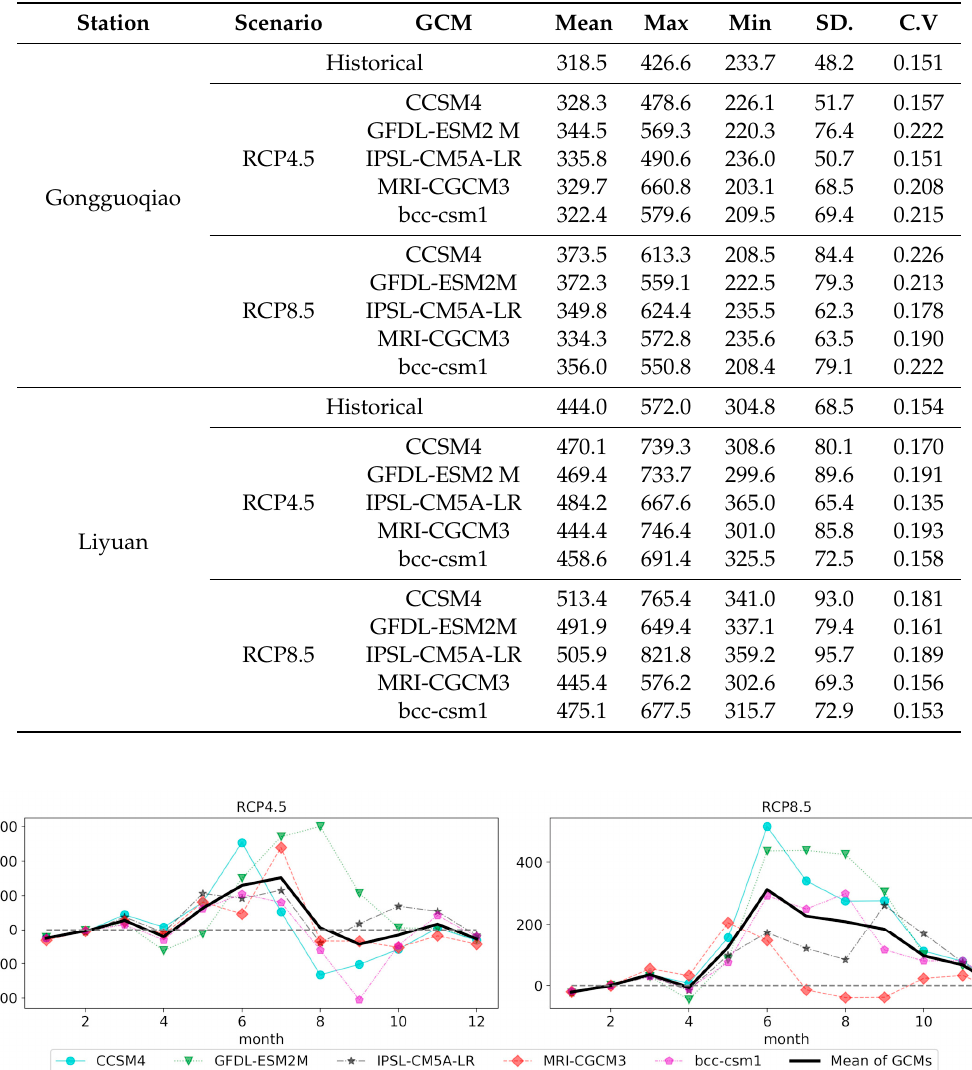
Table 4. The statistics for yearly inflow at typical stations (unit: 10 8 m 3 ).